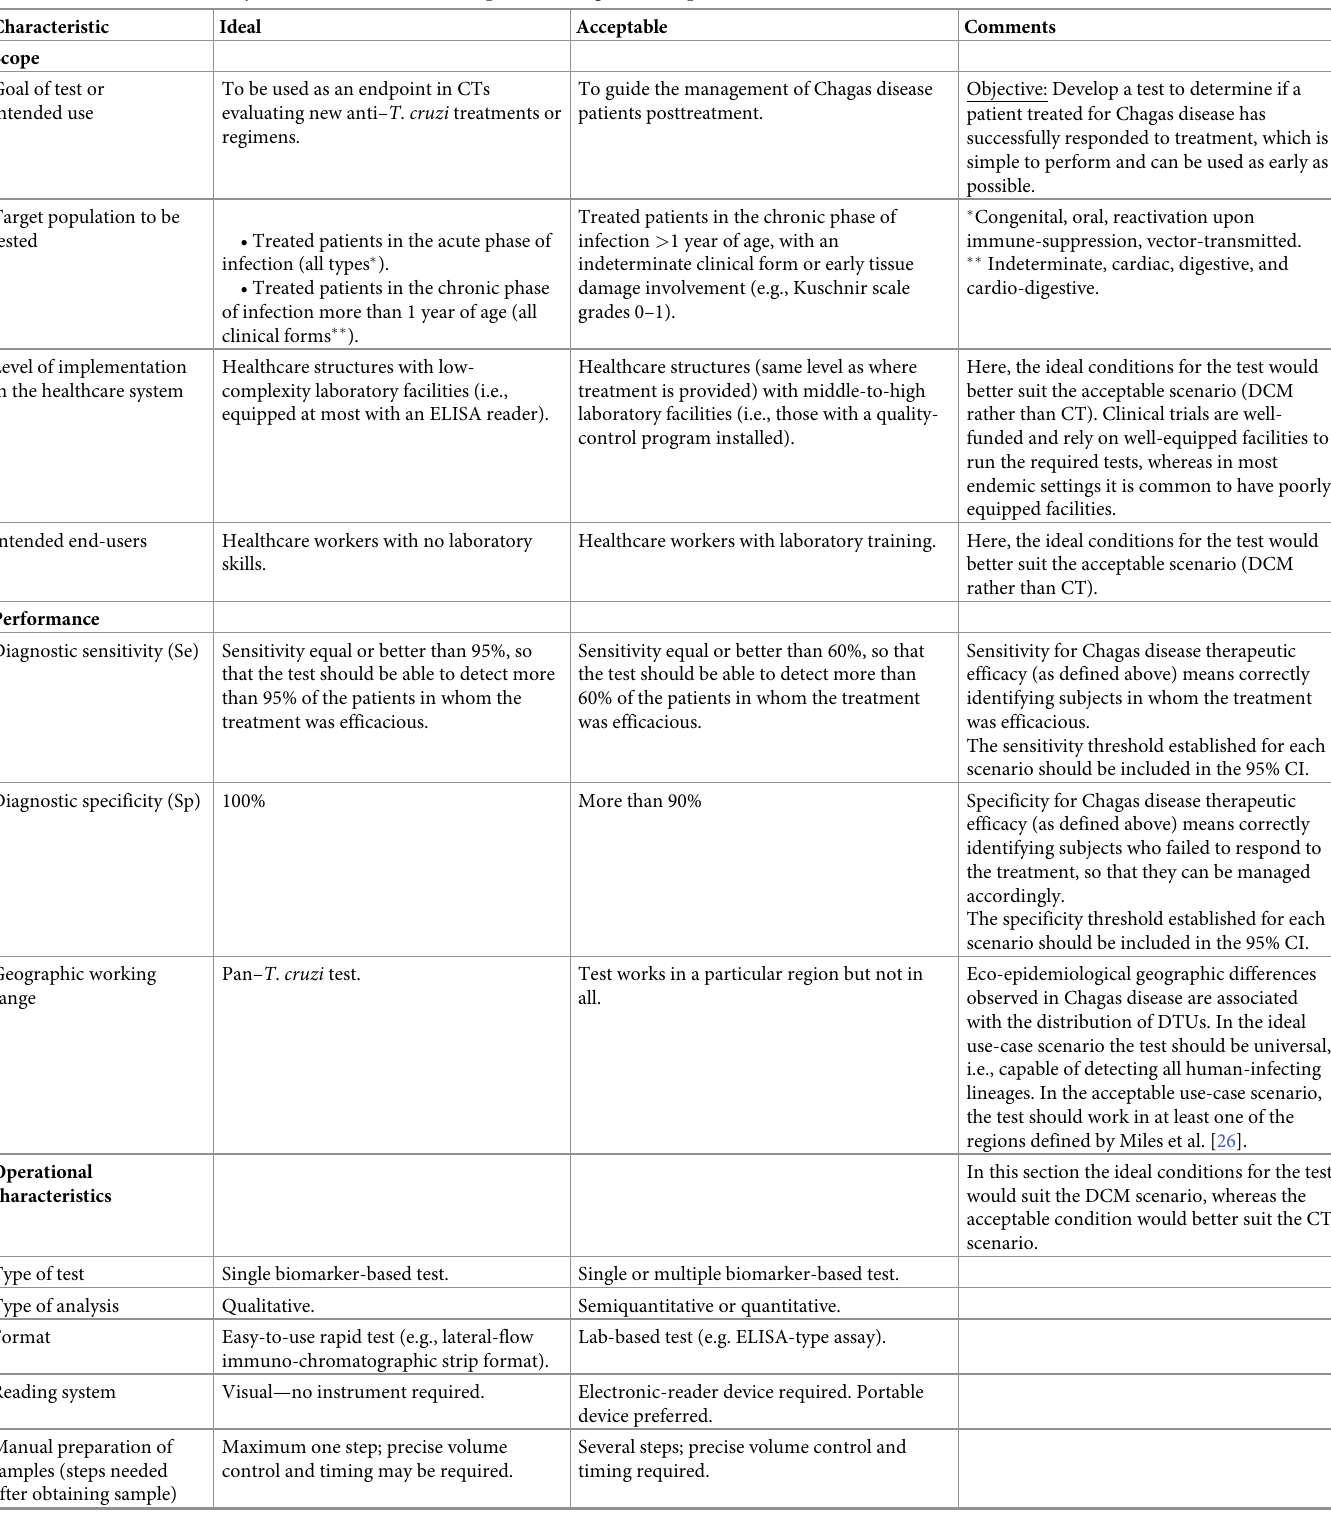
Table 2. TPP for a test for early assessment of treatment response in Chagas disease